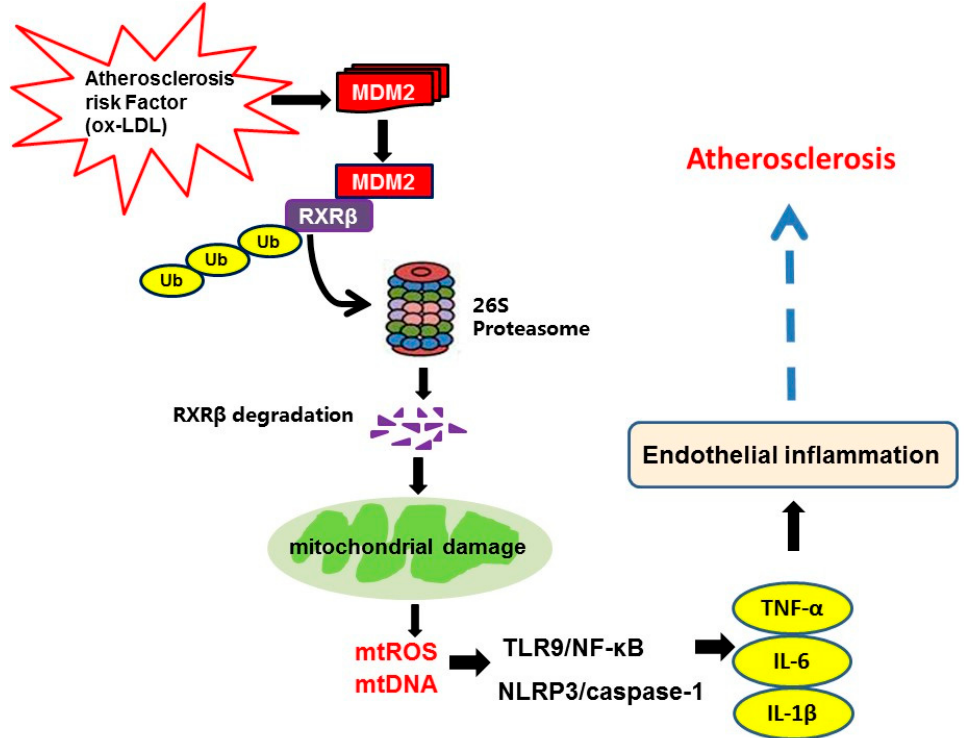
Figure 10. Illustration of the mechanism by which MDM2-mediated ubiquitination of RXR β con- tributes to atherosclerosis. Under conditions that lead to atherosclerosis, such as upon prolonged exposure to ox-LDL in endothelial cells, the expression of MDM2 is induced, and MDM2 functions as a ubiquitin E3 ligase for RXR β . MDM2 promotes RXR β poly-ubiquitination and degradation by proteasomes, which contributes to mitochondrial damage. Subsequently, the elevated amounts of mtROS and release of mtDNA active TLR9/NF- κ B pathway and NLRP3/caspase-1 inflammasome, which further produces pro-inflammatory cytokines TNF- α , IL-6 and IL-1 β in endothelial cells and finally promotes the progression of